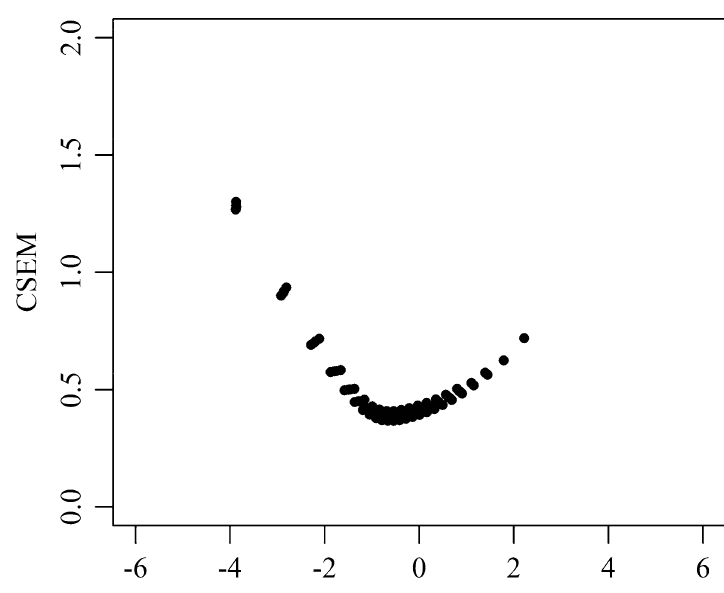
Fig. 9 SES Index and the CSEM for